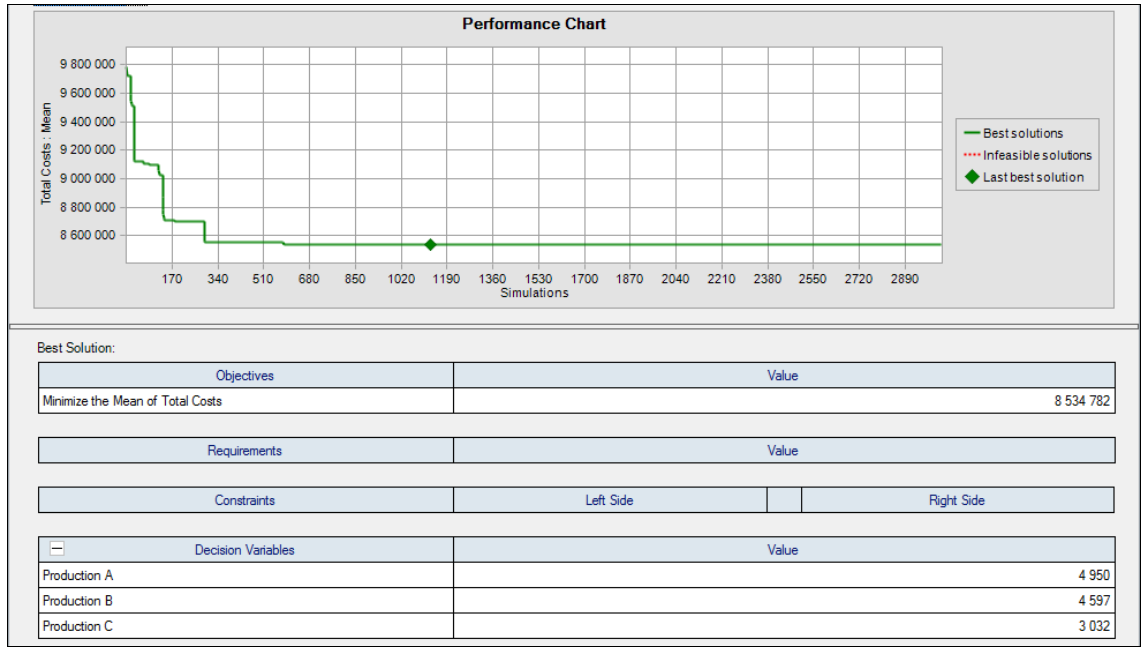
Figure 8: Graph of production optimization with resulting values. Table 6: Production parameters after optimization.